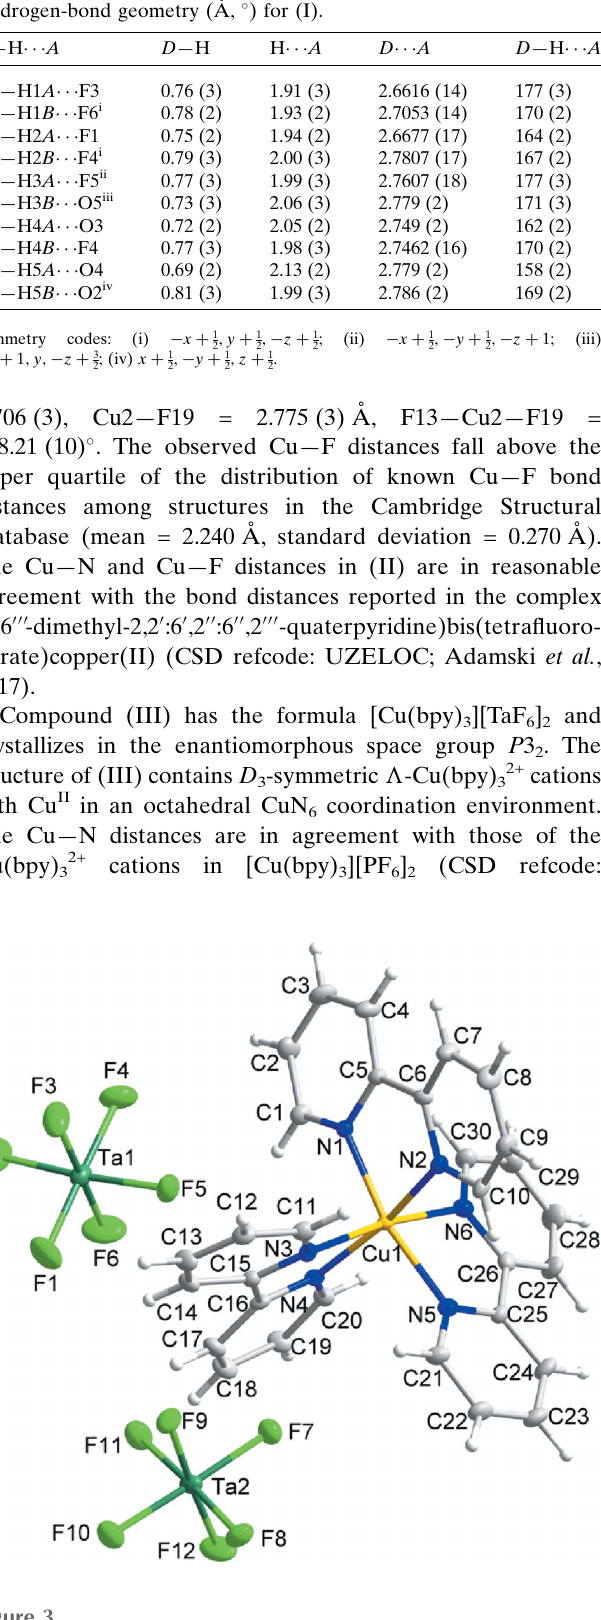
Figure 3 The molecular structure of (III). Ellipsoids of non-H atoms are drawn at 50% probability. H atoms are drawn with an atomic radius of 0.135 A˚ .